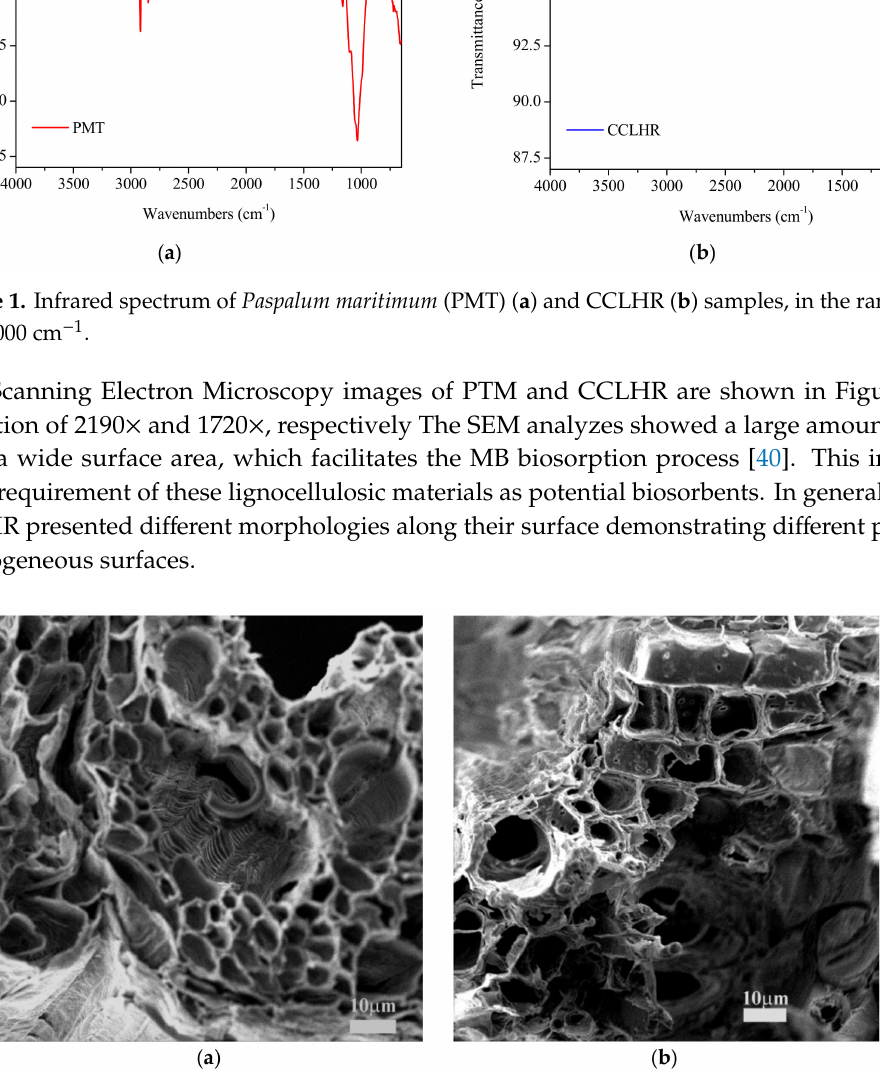
Figure 2. Scanning electron microscope (SEM) image of ( a ) PMT with magnification of 2190 × and ( b ) CCLHR with magnification of 1720 ×